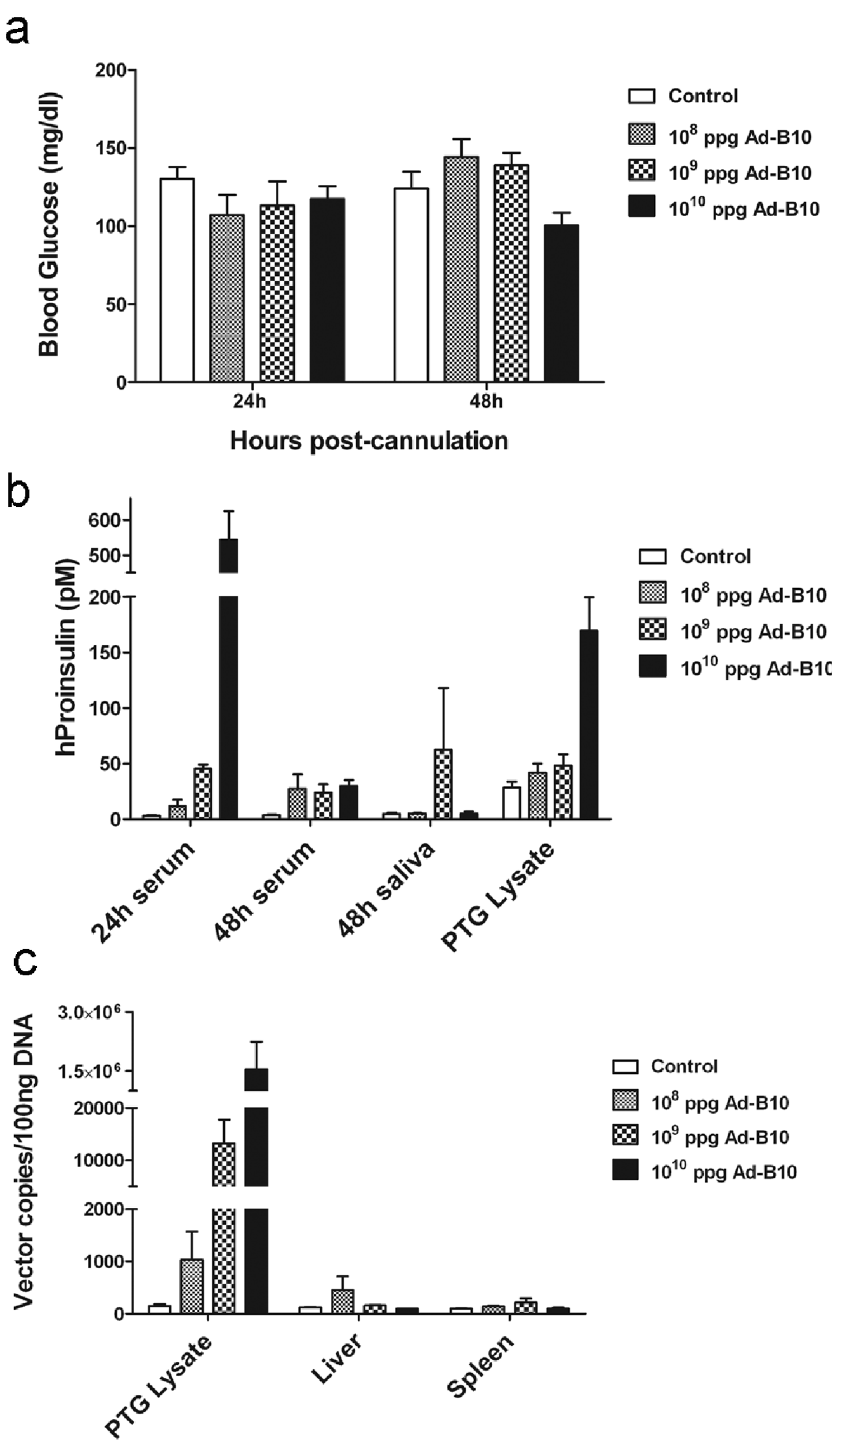
Figure 4. rAd-proinsulin-B10 transduced PTGs secrete hProinsulin to the circulation and restrict extra-glandular vector dissemination. rAd-proinsulin-B10 or saline (Control) was delivered to both PTGs of non-diabetic mice by retroductal infusion. Blood samples were obtained at 24 h and 48 h post-transduction and saliva and PTG samples were collected at the conclusion of the experiment (48 h). ( a ) Blood glucose (mg/dl) measurements at 24 h and 48 h post-transduction. No statistical difference in glucose levels was observed between groups (ANOVA) ( b ) Sera, saliva and PTG protein lysates were assayed for hProinsulin (pM) by ELISA. ( c ) QPCR analysis of rAd vector genome distribution in tissues at the conclusion of the experiment. Data are expressed as rAd genome copies detected in 100 ng of genomic DNA. For all panels, ppg=particles per gland and bars indicate mean + SEM of n=4 mice for 10 9 ppg and Control groups, and n=5 for all other groups.